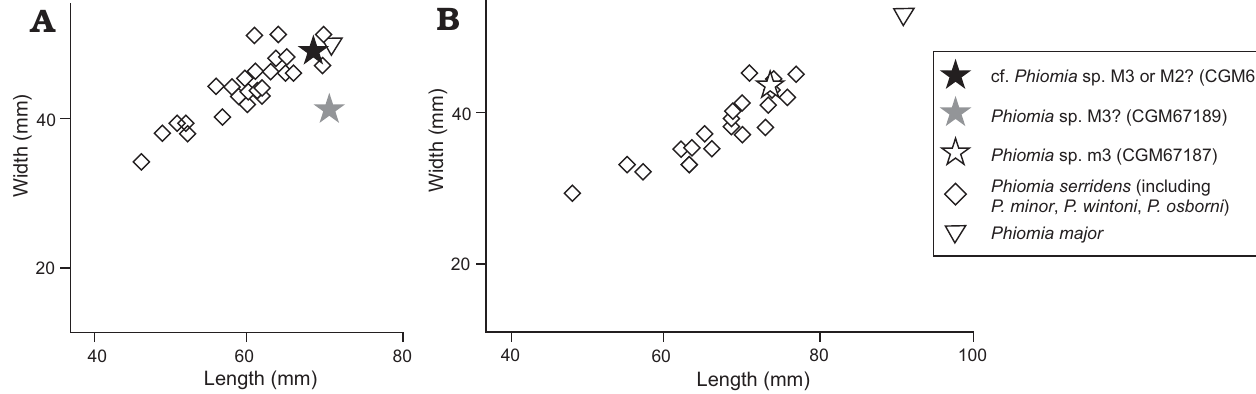
Fig. 7. Bivariate plots of Phiomia sp. cheek teeth from the BOTM, early Oligocene, Minqar Tibaghbagh, Qattara Depression, Egypt (stars) compared with Phiomia spp. from the early Oligocene Jebel Qatrani Formation, Fayum Depression, Egypt (diamonds) and Phiomia major from the late Oligocene, Chilga Formation of the Chilga Region, Ethiopia (triangles). Comparative dimensions of Phiomia serridens from Matsumoto (1924: 48, tables B, C, E, G); dimensions of Phiomia major from Sanders et al. (2004: table 2). A . M3? (or M2?) and M3?, originally the latter molar would have been larger in width (see text). B . m3 , the width is based on estimated dimensions.